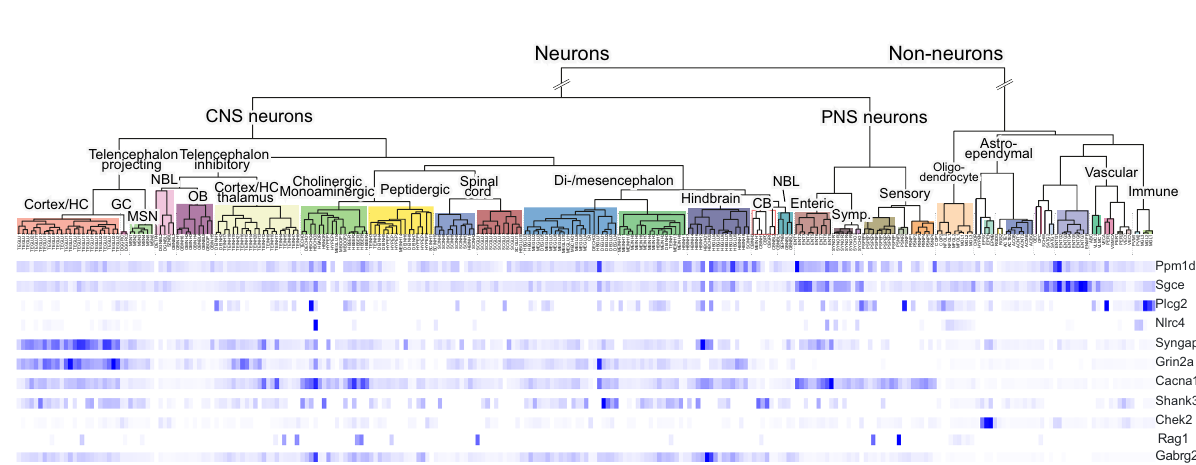
Figure 4. scRNA-seq expression pattern of each PANS candidate gene in mouse adolescent brains (open access article; CC BY license http:// creat iveco mmons. org/ licen ses/ by/4.